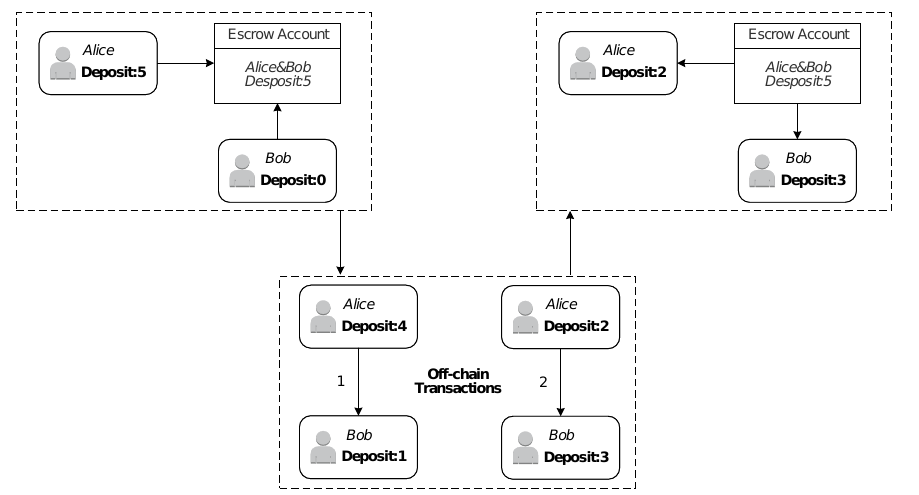
Figure 1. An example of off-chain payment channel transaction.